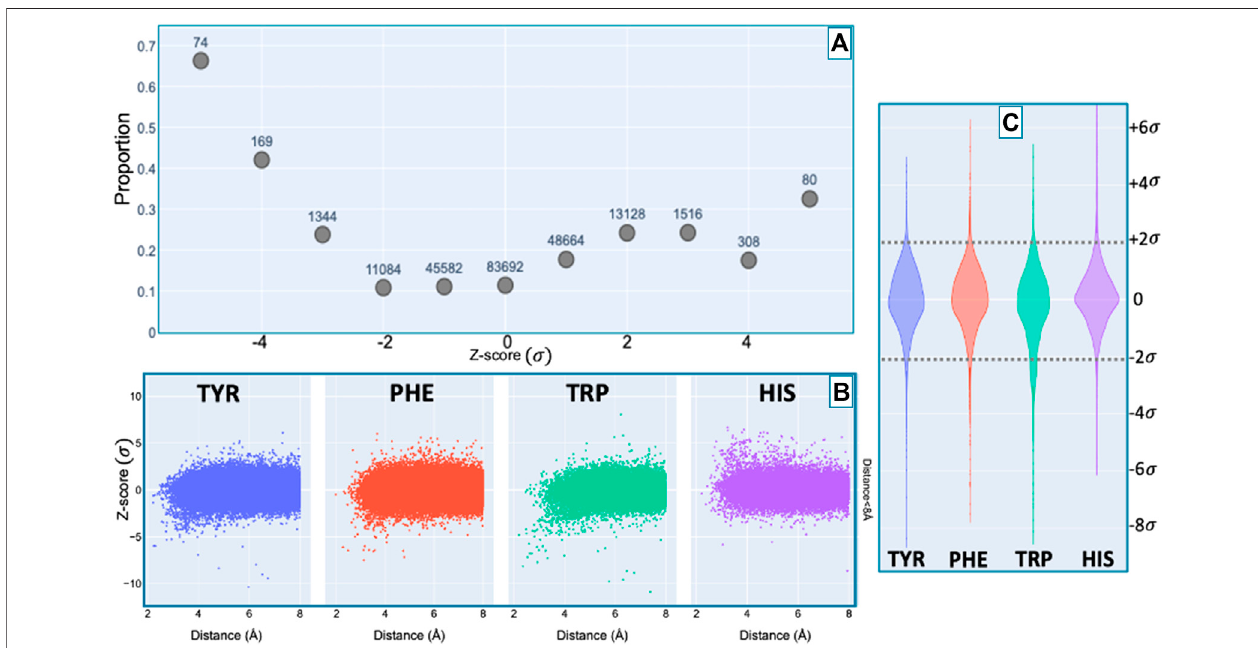
FIGURE7| Fraction ofamide protonswith oneormore NOE restraint toanaromatic ring proton( y -axis),asafunctionoftheZ-scoreoftheamide proton( x -axis)is shown in panel (A) . Proportions are calculated with respect to the total number of amide hydrogens with chemical shifts reported in entries with at least one amide- aromaticrestraint. Thenumbers overeach point inpanel (A) are thetotalnumber ofsuch amides (includingthose lackingany NOE restraints toanearbyaromatic)at the correspondingZ-scoreinunitsofstandarddeviation σ .Thescatterplotsinpanel (B) showsthedistributionofamidechemicalshiftsofaminoacids(HIS,TRP,PHE, TYR) as afunction of distance (for distancesless than 8 Å) ofthe amide proton from the center ofthe nearest aromaticring. ForZ-score values between − 2 σ and 2 σ , the restrainedamideprotonsfractionsaregenerallyconsistentamongaminoacidsstudied.However,outsidetherangeof − 2 σ to2 σ ,thetrendofrestrainedamideprotonsis dependent on the amino acid (HIS, TRP, PHE, TYR). The violin plot in panel (C) illustrates the dependence of this trend on the amino acids.